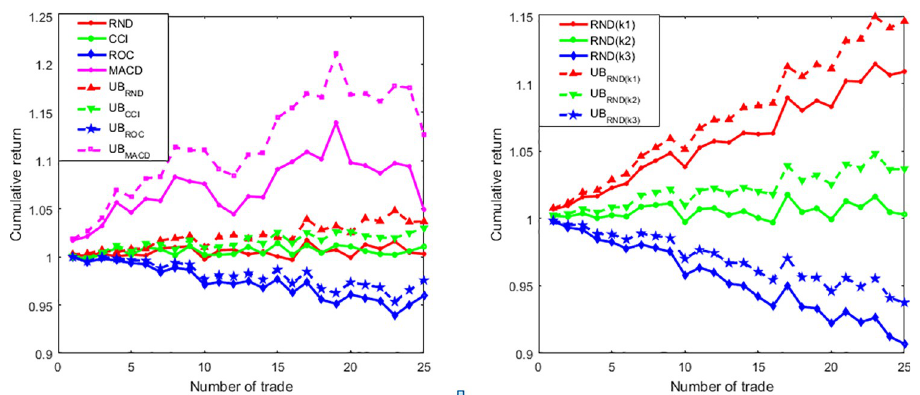
Fig 3. Validation of the upper bound of the cumulative return for DJIA. Here left sub-graph shows the cumulative return and its upper bound with different trading strategies (k = 0.005). While right sub-graph shows the cumulative return and its upper bound with transaction cost rate. k1, k2 and k3 take 0.003, 0.005 and 0.007, respectively. Notably, UB represents the upper bound. As shown in Fig 3, the upper bound can always be held, regardless of trading strategies and transaction cost rate.